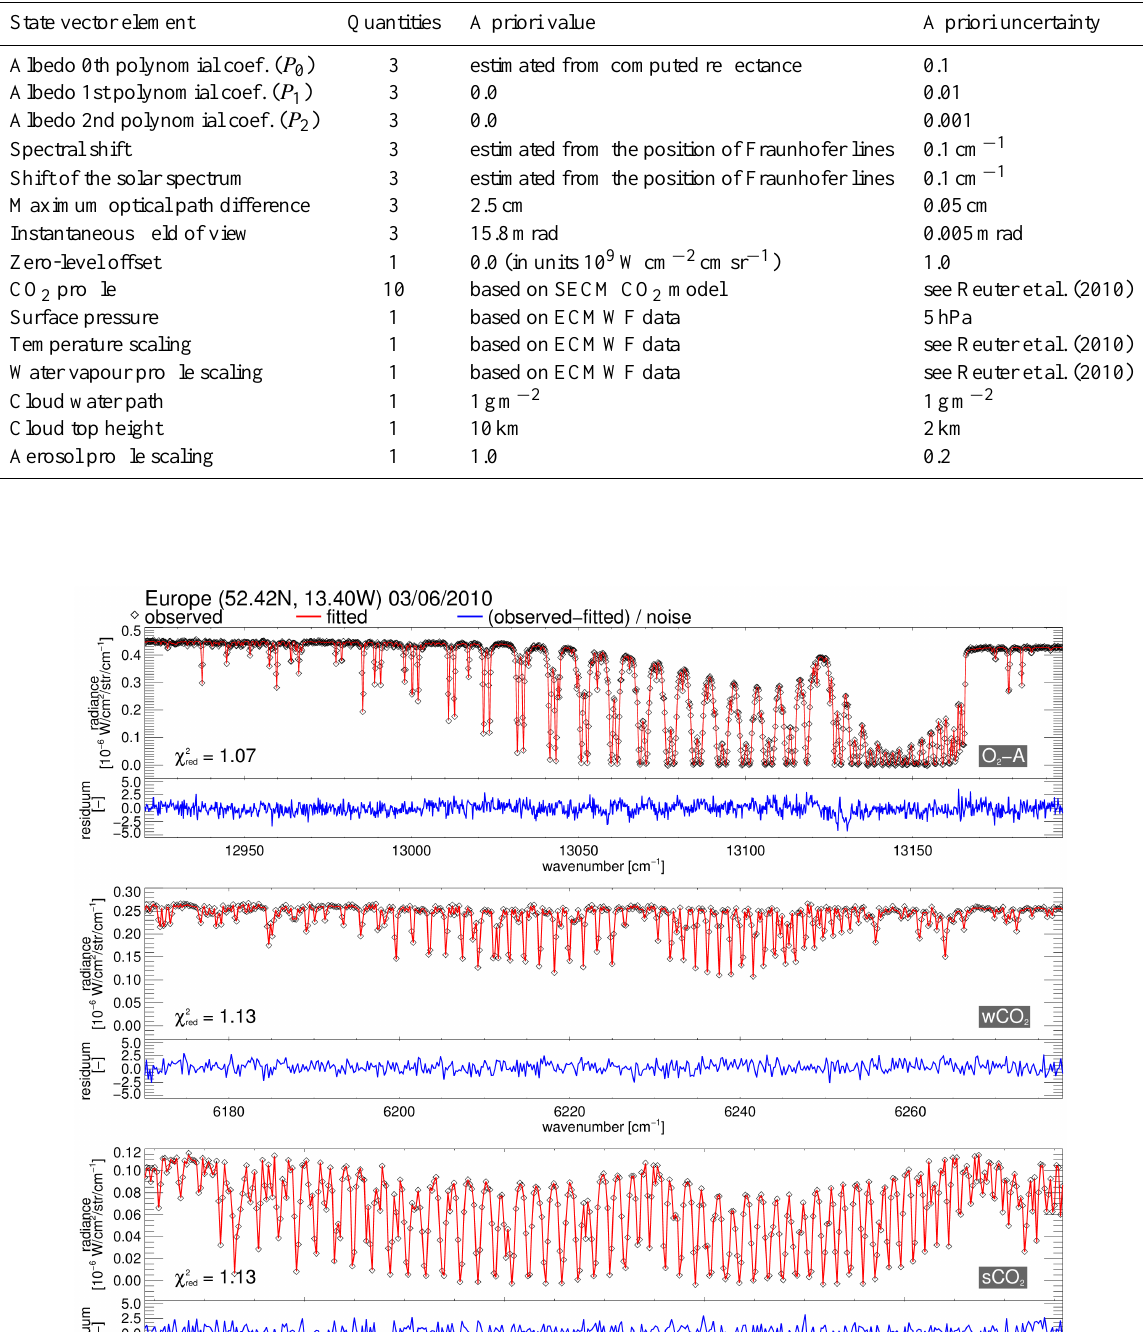
Table 2. State vector elements of the GOSAT BESD retrieval algorithm.